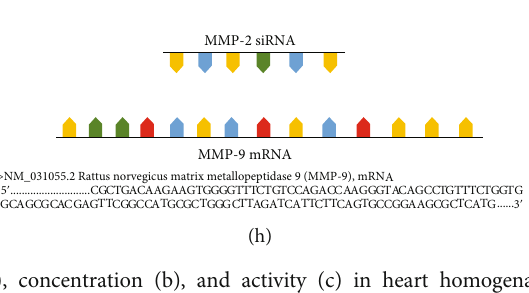
Figure 2: MMP-2 gene expression (a), concentration (b), and activity (c) in heart homogenates and MMP-9 gene expression (d), concentration (e), and activity (f) in the heart tissue. Representative zymogram of MMP-2/MMP-9 activity in heart homogenates (HT10- 80 and PRP were used as standards for pro-/active MMP-2 and MMP-9) (g). Graph presenting the site of siRNA binding to the fragment of MMP-9 mRNA sequence (h). Aero: aerobic control group; I/R: ischemia/reperfusion; MMP-2: matrix metalloproteinase 2; MMP-9: matrix metalloproteinase 9; PRP: platelet-rich